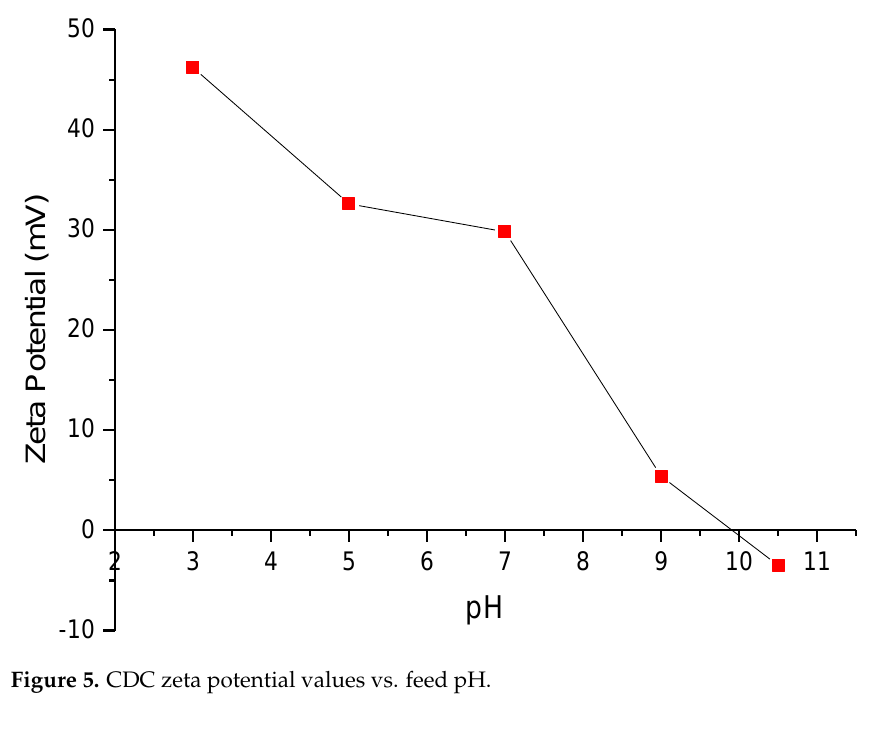
Figure 5. CDC zeta potential values vs. feed pH.